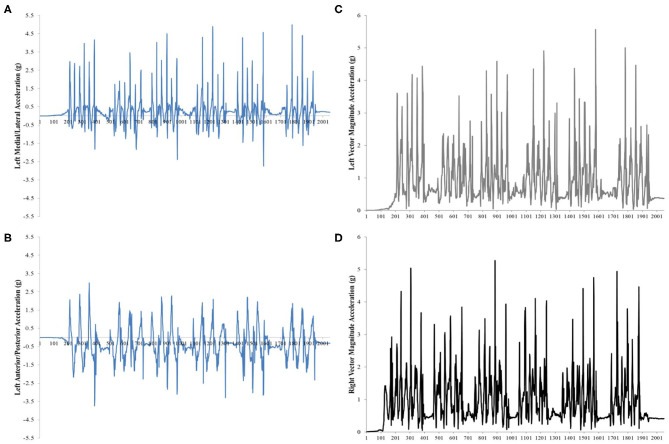
(A–D) Example acceleration data (g) of one test attempt of the modified Edgren Side Step Test (mESST). (A) Left Medial/Lateral acceleration, (B) Left Anterior/Posterior acceleration, (C) Vector magnitude of the Left Medial/Lateral and Anterior/Posterior acceleration data (g), (D) Vector magnitude of the Right Medial/Lateral and Anterior/Posterior acceleration data (g).